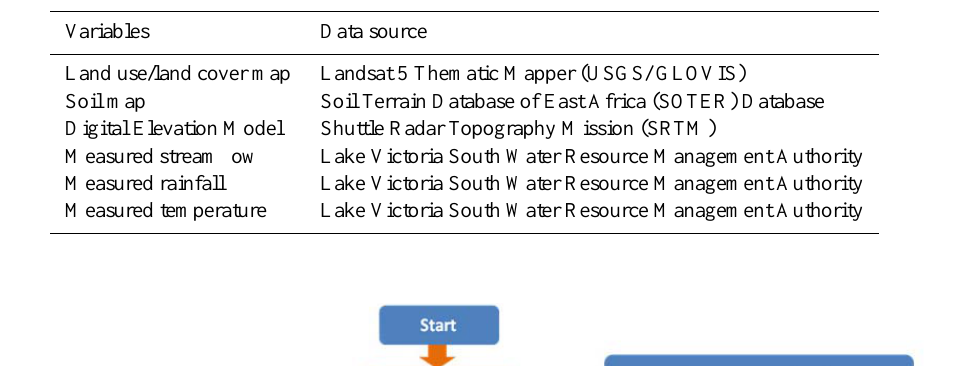
Table 1. Variables used in the SWAT model and data sources.